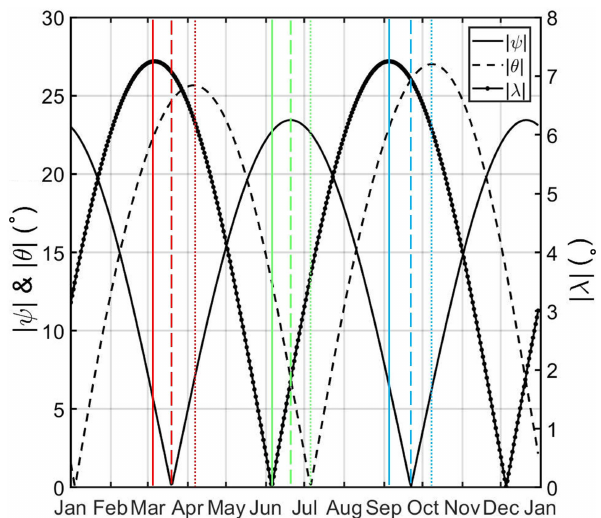
Figure 1. Annual profiles of the absolute value of the λ angle gov- erning the axial mechanism (dotted black line), the solar declination ψ governing the equinoctial mechanism (solid black line) and the θ angle responsible for the Russell–McPherron effect (dashed black line). The vertical lines correspond to the equinoxes’ maxima (red and blue) and the summer solstice minimum (green) derived from the three mechanisms (Cliver et al.,